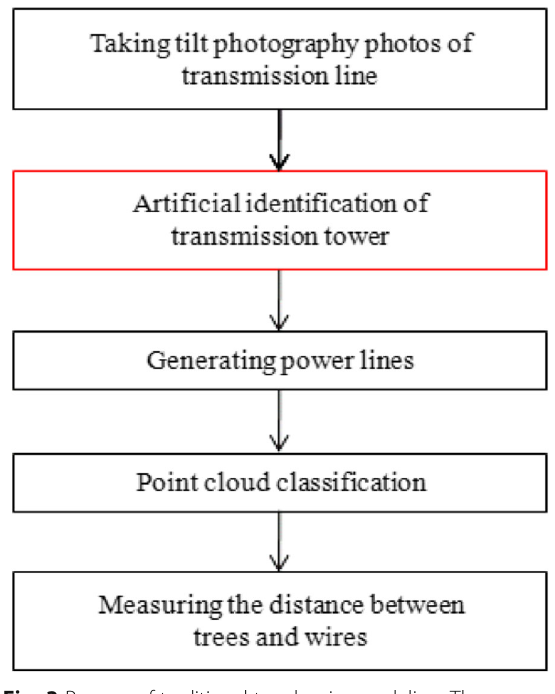
Fig. 3 Process of traditional tree barrier modeling. The process includes five steps, they are taking tilt photography photos of transmission line, artificial identification of transmission tower, generating power lines, point cloud classification, measuring the distance between trees and